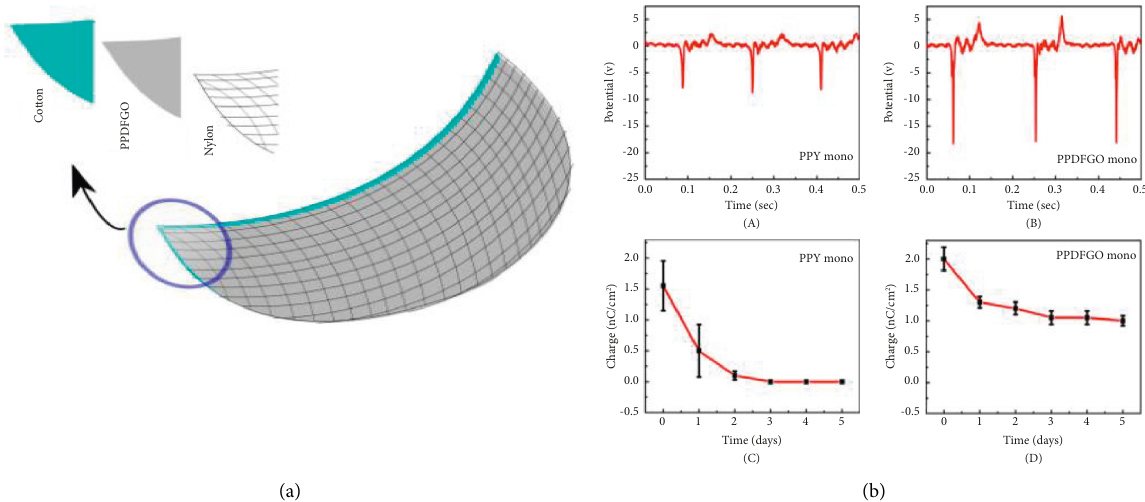
Figure 4: (a) Potential of PPY, (b) potential of PPDFGO composite, (c) charge of PPY, and (d) charge of PPDFGO composite (adapted with permission from ref. [37]).